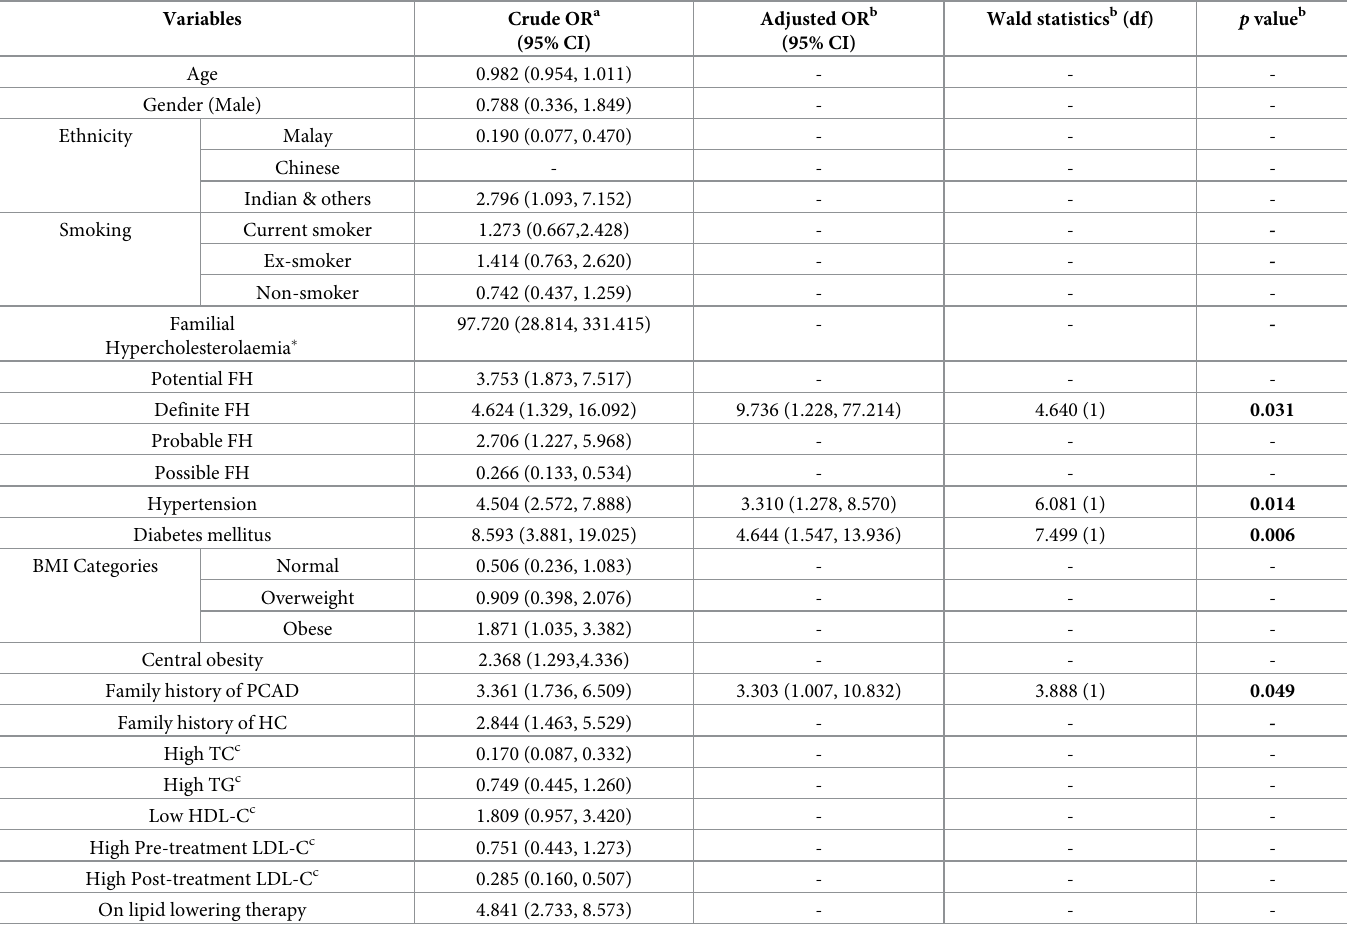
Table 3. Factors associated with PCAD among individuals with clinically diagnosed FH [DLCC score > 3]; (n = 246).